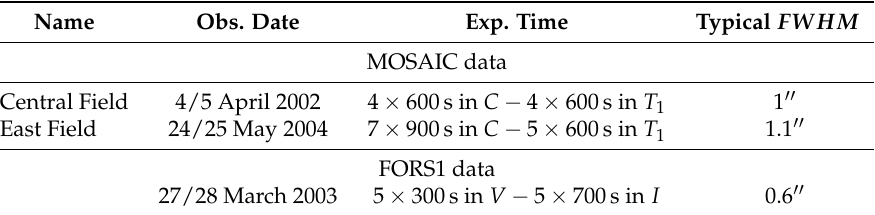
Figure 1. The MOSAIC (white regions) and FORS1 (black regions) fields are overlaid on a 70 × 70arcmin 2 DSS image of the Antlia cluster. North is up and east is to the left. Table 1. Basic data from observations. FWHM: full width at half